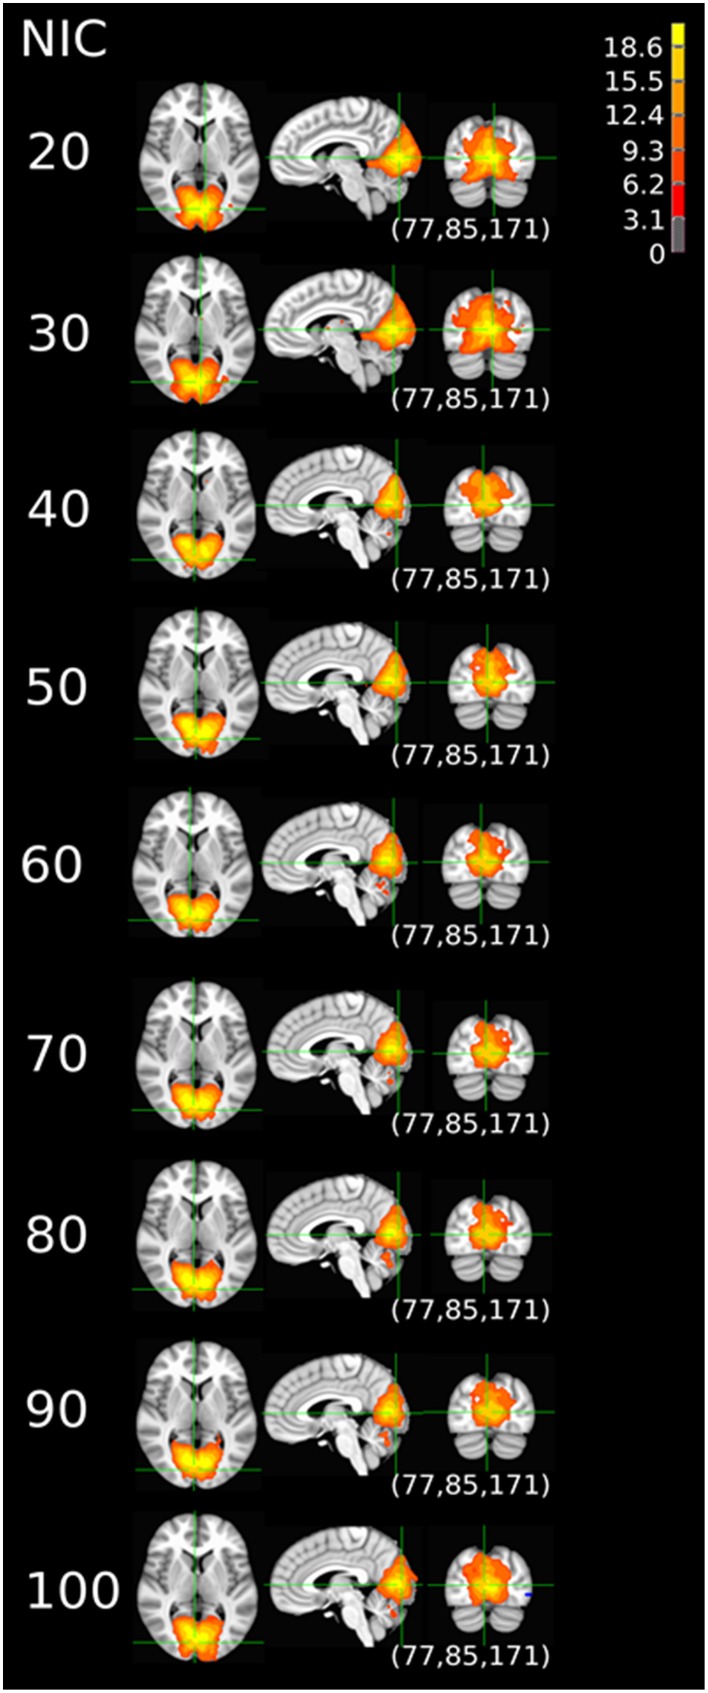
The tracking results of dataset 4 for a typical RFN through similarity matching. The DMN was tracked at NIC = 20–100. An anterior and inferior split-offs were detected at NIC = 40 and 80, respectively.